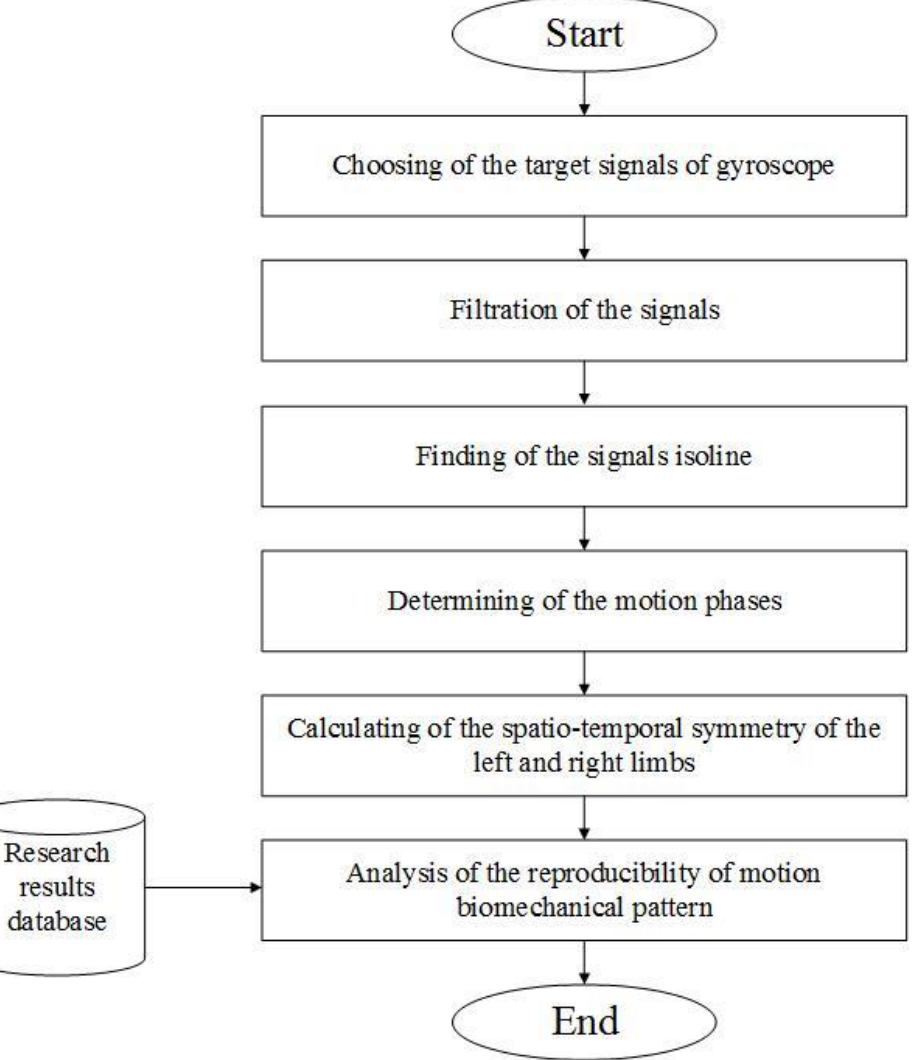
Figure 4 . The analysis algorithm of the biomechanical pattern of